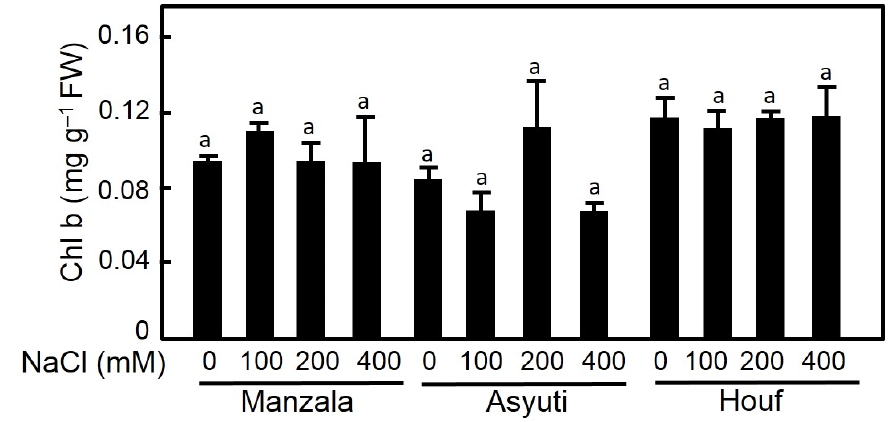
Figure 8. Effects of 45 days salt treatments (0, 100, 200 and 400 mM NaCl) on chlorophyll b in Z. coccineum from Manzala, Wadi Asyuti and Wadi Houf. Value represents the mean of 3 replicates ± standard error, p -value < 0.05. For variables denoted with the same letter, the difference is not statistically significant.